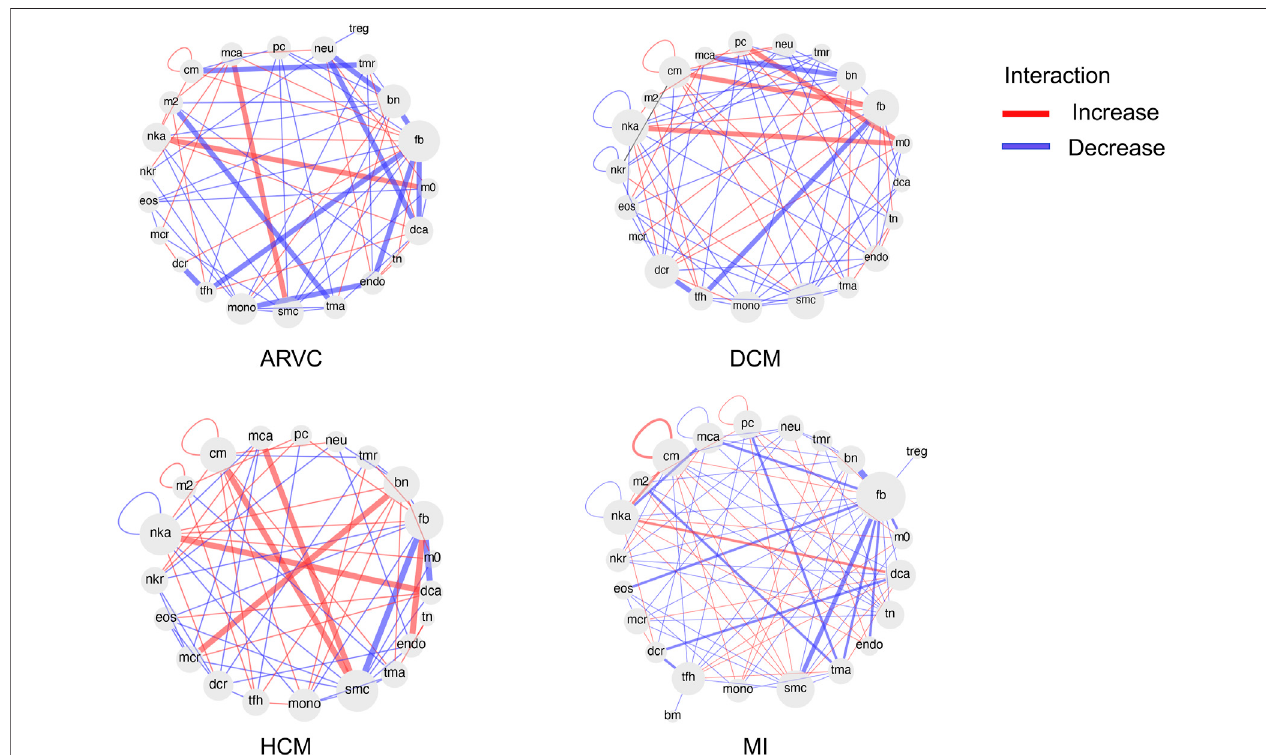
FIGURE7| Differentialcell – cellcommunicationnetworkbasedonligandreceptoranalysis.Foreachdiseasecondition,thedifferentialcell – cellcommunicationnetwork incomparison withthehealthy controlsisshown.Eachcelltypeisshown asanodeinthenetwork.Thered linksbetween nodes representenhancedinteractionsbetween twocelltypes inthe diseasecondition,while the bluelinks represent reduced interactions. The abbreviationsofcelltypes are denoted asfollows:cm, cardiomyocyte;mca, mastcellactivated;pc,plasmacell;neu,neutrophil;treg,Tcellregulatory;tmr,Tcellmemoryresting;bn,Bcellnaïve;fb, fi broblast;m0,macrophageM0;dca,dendritic cellactivated;tn,Tcellnaïve;endo,endothelialcell;tma,Tcellactivated;smc,smoothmusclecell;mono,monocyte;tfh,Tcellfollicularhelper;dcr,dendriticcellresting;mcr, mast cell resting; eos, eosinophil; nkr, NK cell resting; nka, NK cell activated; nkr, NK cell resting; m2, macrophage M2; bm, B cell memory.